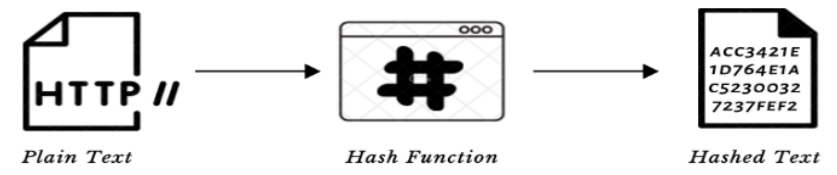
Figure 2. Hash function process.